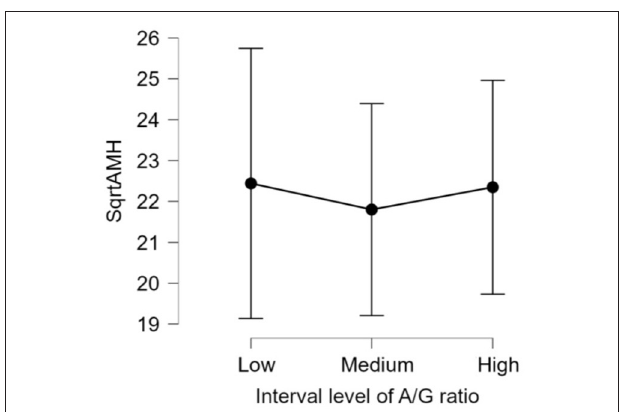
FIGURE 5 | The 95% confidence interval of the mean for each group. The mean and standard deviation (mean ± SD) score of intervals of albumin/globulin (A/G) ratios are as follows: Low = (0.87 ± 0.10), Medium = (1.09 ± 0.05), and High = (1.33 ± 0.12). The differences in all level are not significant ( p -value = 0.938). AMH, anti-Müllerian hormone; A/G, albumin/globulin ratio.